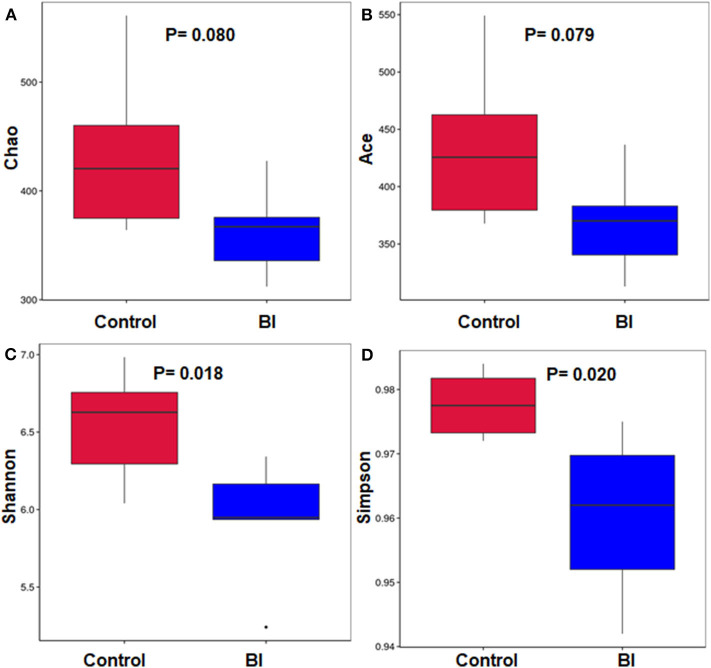
The richness and diversity of the bacterial community in the control group and 2% BI administration group. (A) Chao index; (B) Ace index; (C) Shannon index; (D) Simpson index. Control, control diet; BI, B. inquinans.